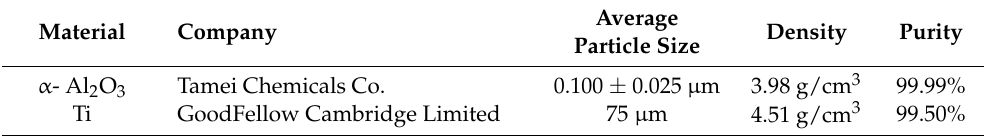
Table 1. Specification of the powders used in the research based on manufacturers’